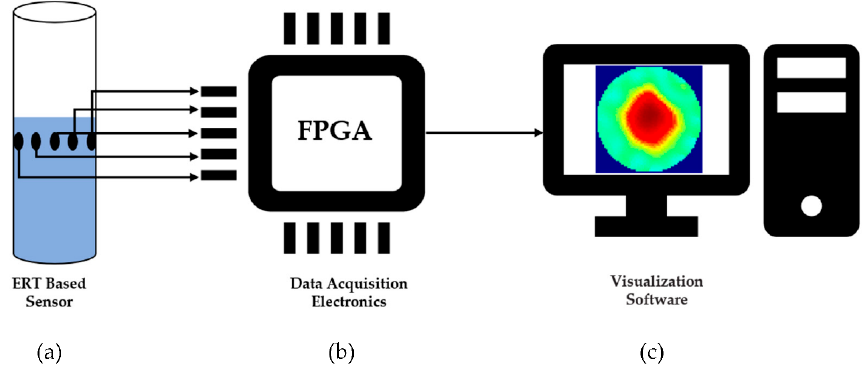
Figure 2. Structure of typical ERT system showing: ( a ) ERT Based sensor ( b ) Data acquisition electronics ( c ) Image reconstruction and visualization software.